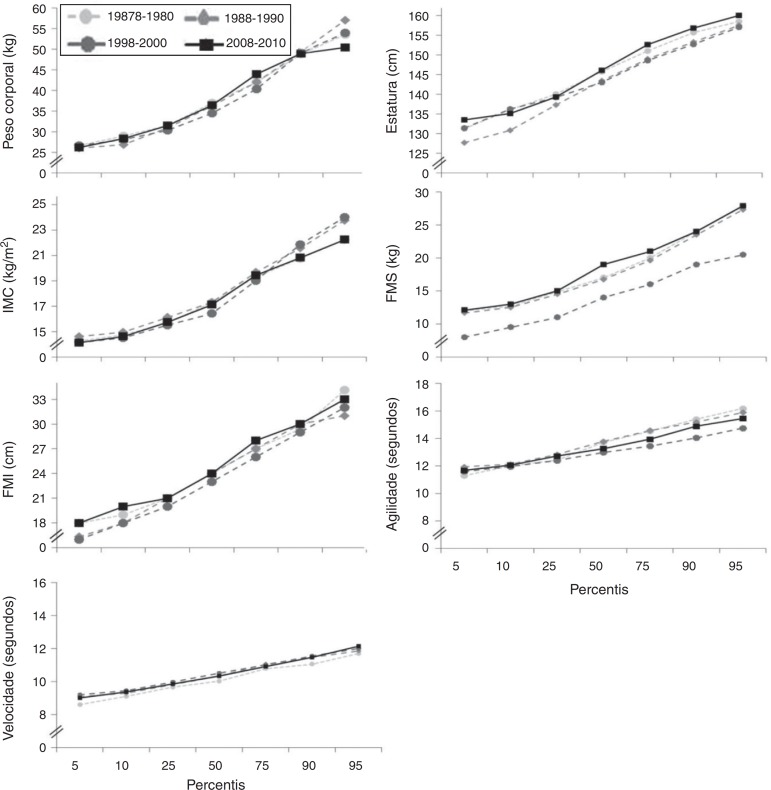
Valores de percentis para cada variável de aptidão física independentemente
do estado nutricional em 30 anos, no sexo feminino. FMS, força de membros
superiores; FMI, força de membros inferiores.